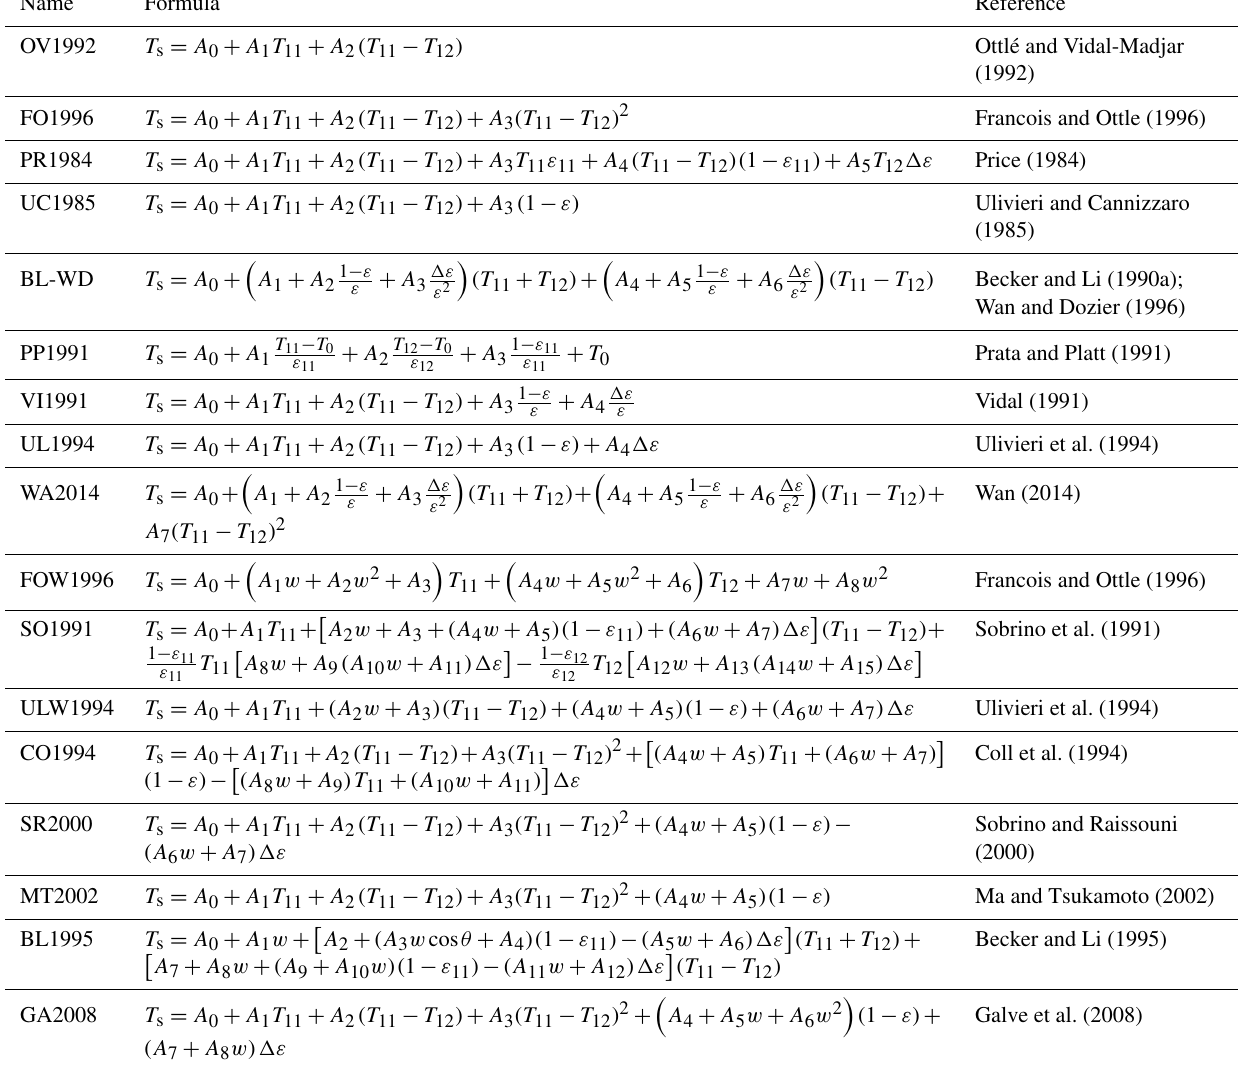
Table 5. Initial candidate split-window algorithms